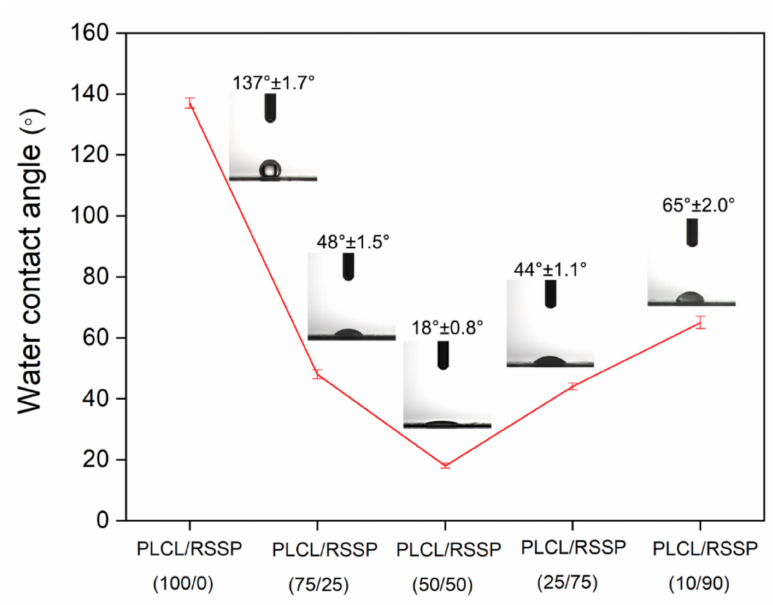
Figure 2. Water contact angles of the nanofibrous membranes.